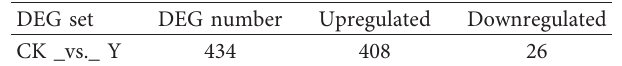
Table 3: The number of differentially expressed genes of P. expansum treated with M. guilliermondii (Y) and P. expansum